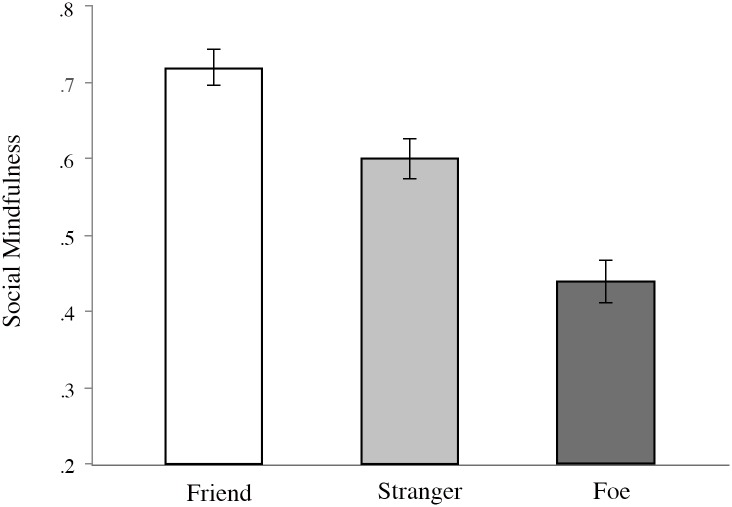
Mean scores on social mindfulness per condition in Study 1.Error bars represent standard error.